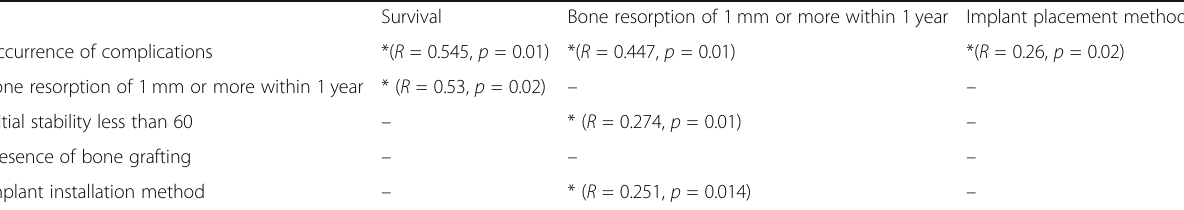
Table 8 Correlation between factors (* p < 0.05)